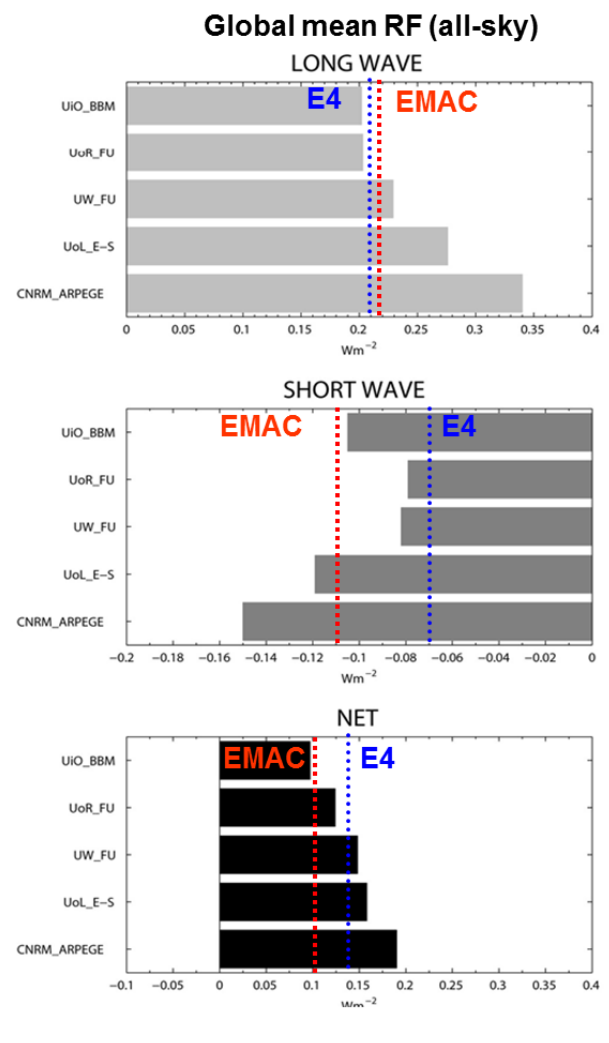
Fig. 12. Global means for the longwave (top), shortwave (mid) and net RF (bottom) for the contrail RF benchmark test (see text for details). Figure is adapted from Myhre et al.